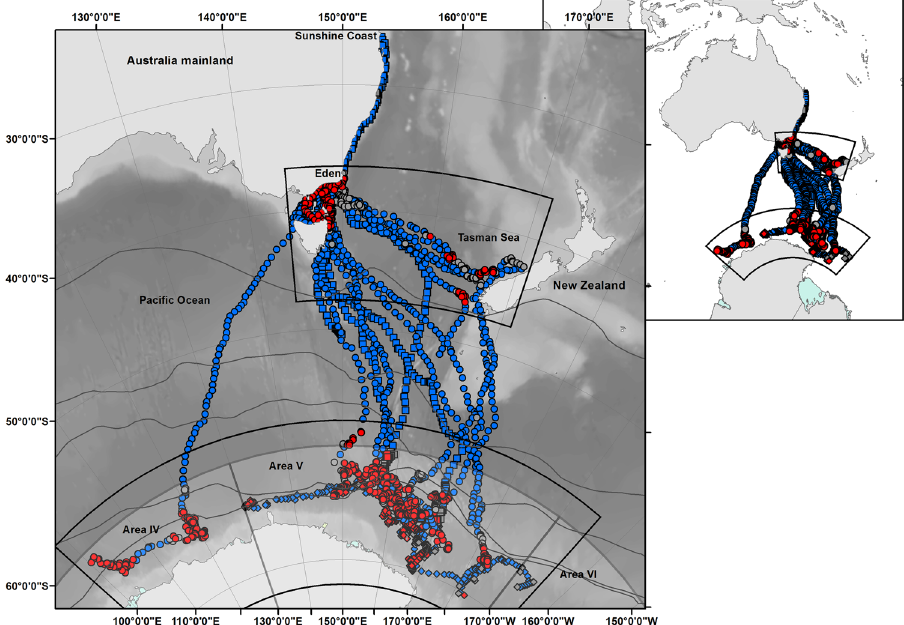
Figure 1. Migration pathways for 30 humpback whales satellite-tagged off the eastern coast of Australia. (Eden deployment – circles, Sunshine Coast deployment – squares) and in Antarctica (diamonds). ( a ) Shows tracks across the entire geographic range and depicts IWC Antarctic Management Areas IV, V and VI as white boxes. Location estimates from the state-space model are coloured according to the behavioural state estimate: ‘search’ (red), ‘transit’ (blue) and ‘uncertain’ (grey). Grey lines show climatological oceanic frontal positions 102 . Background shading indicates bathymetry derived from the GEBCO Digital Atlas 103,104